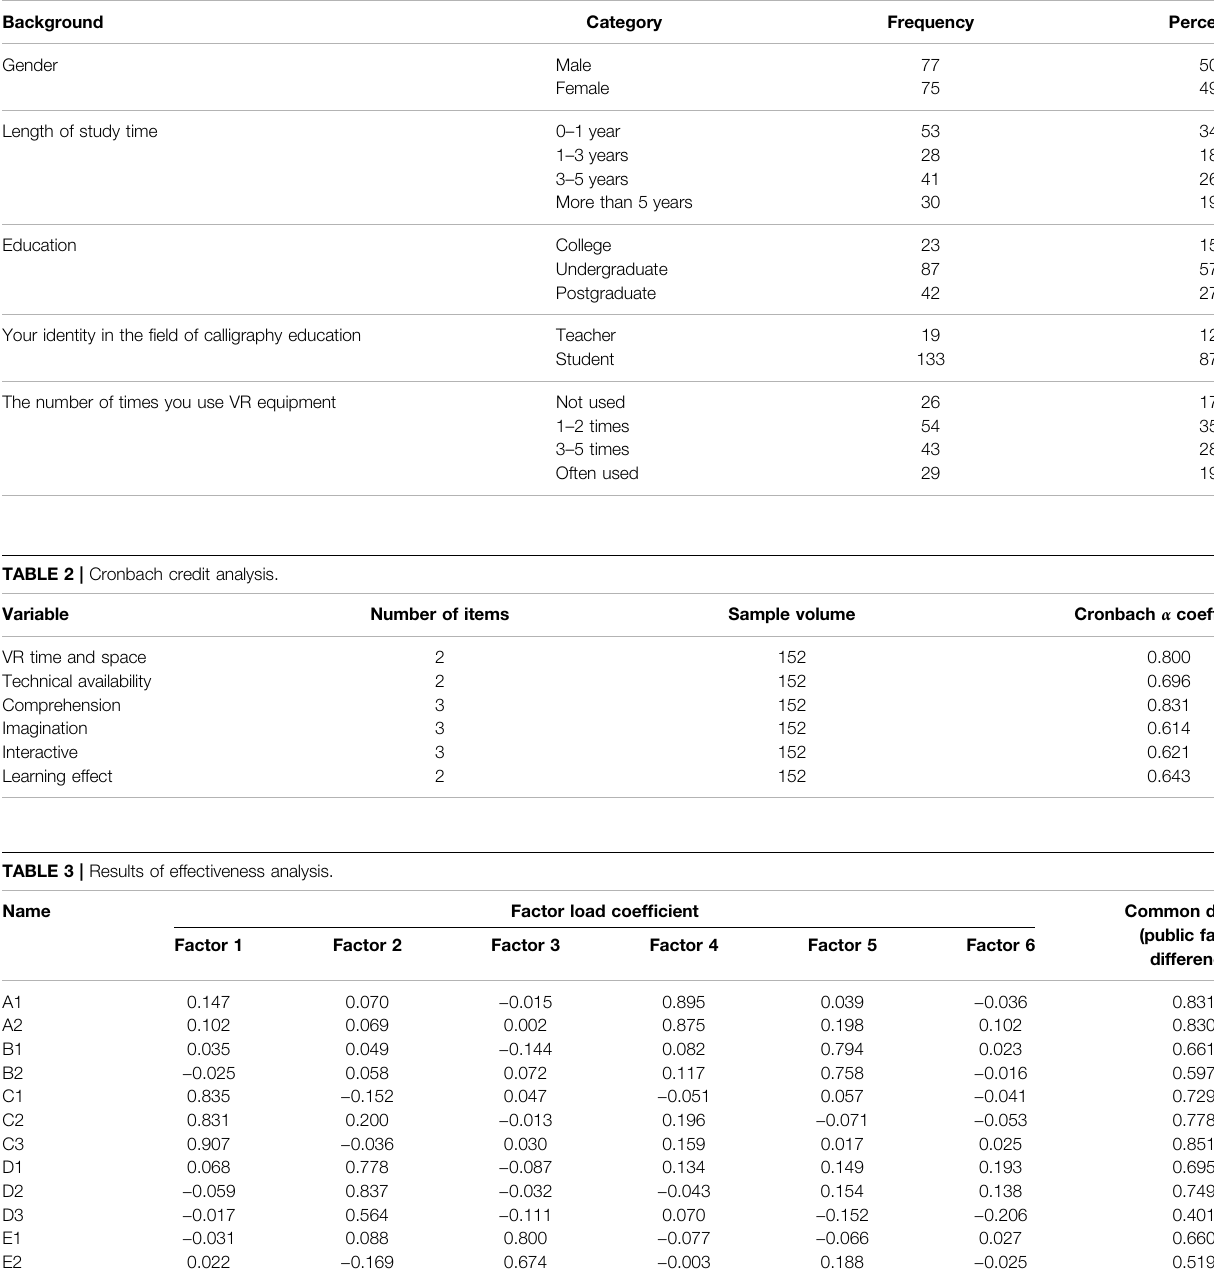
TABLE 1 | Participants ’ sociodemographic features [sample demographics ( N = 152)].